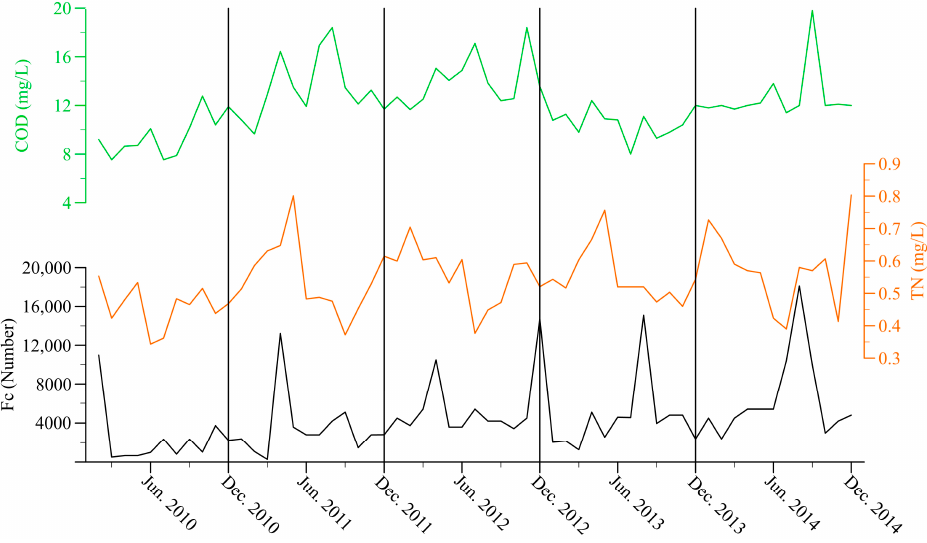
Figure 6. Actual measured values of COD, TN, and Fc. Table 5. Comparison of water quality grades based on game theory-based cloud model using various weights.